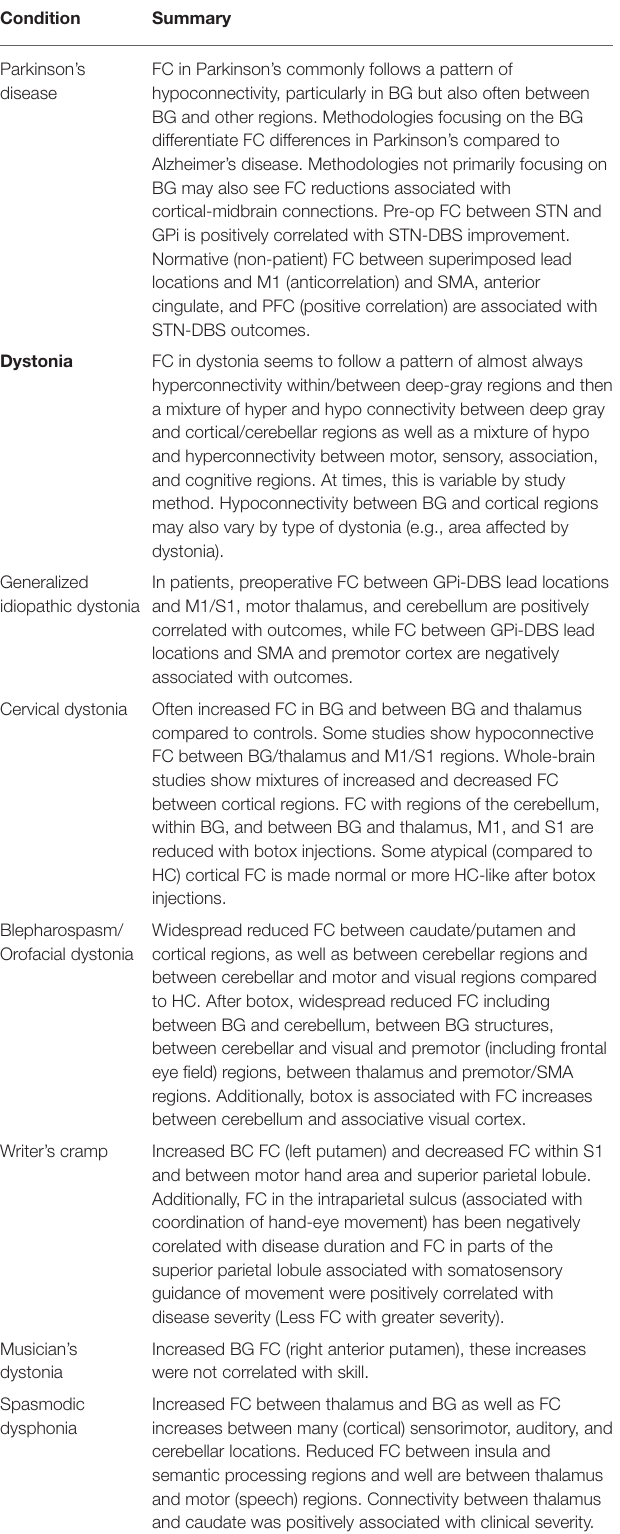
TABLE 1 | Summary of functional connectivity findings reviewed by